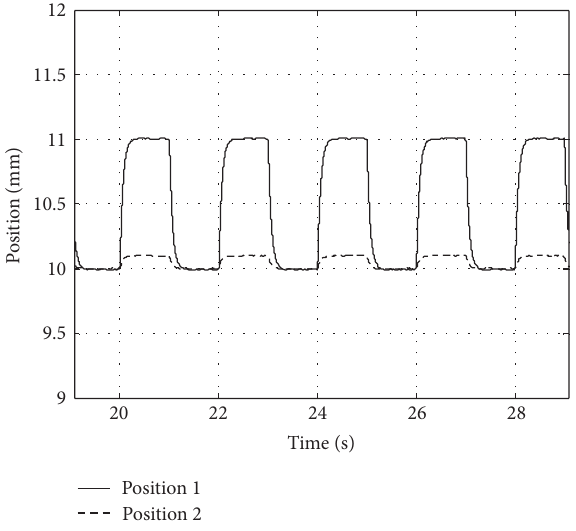
Figure 6: Position curves of algorithm